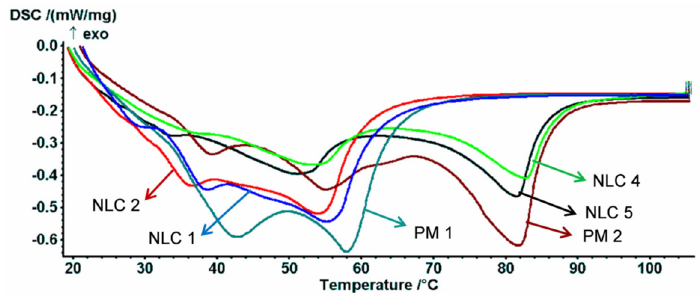
Figure 5. DSC curves of free (NLC 1 and 4) and loaded NLCs (NLC 2 and 5) in comparison to their physical lipid mixtures (PM 1 and 2).